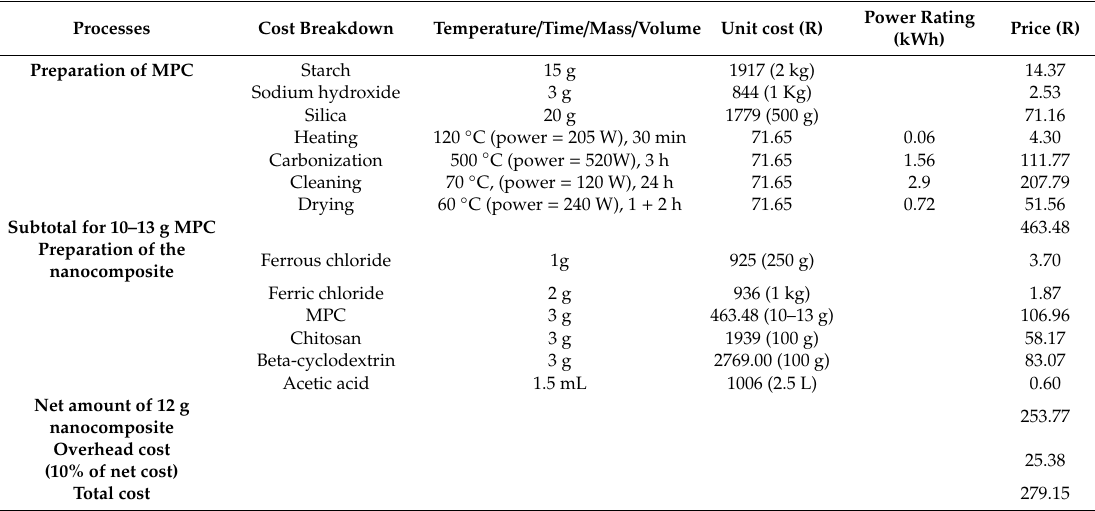
Table 9. Cost estimation breakdown for the production of magnetic mesoporous carbon / β -cyclodextrin– chitosan (MMPC / Cyc-Chit)